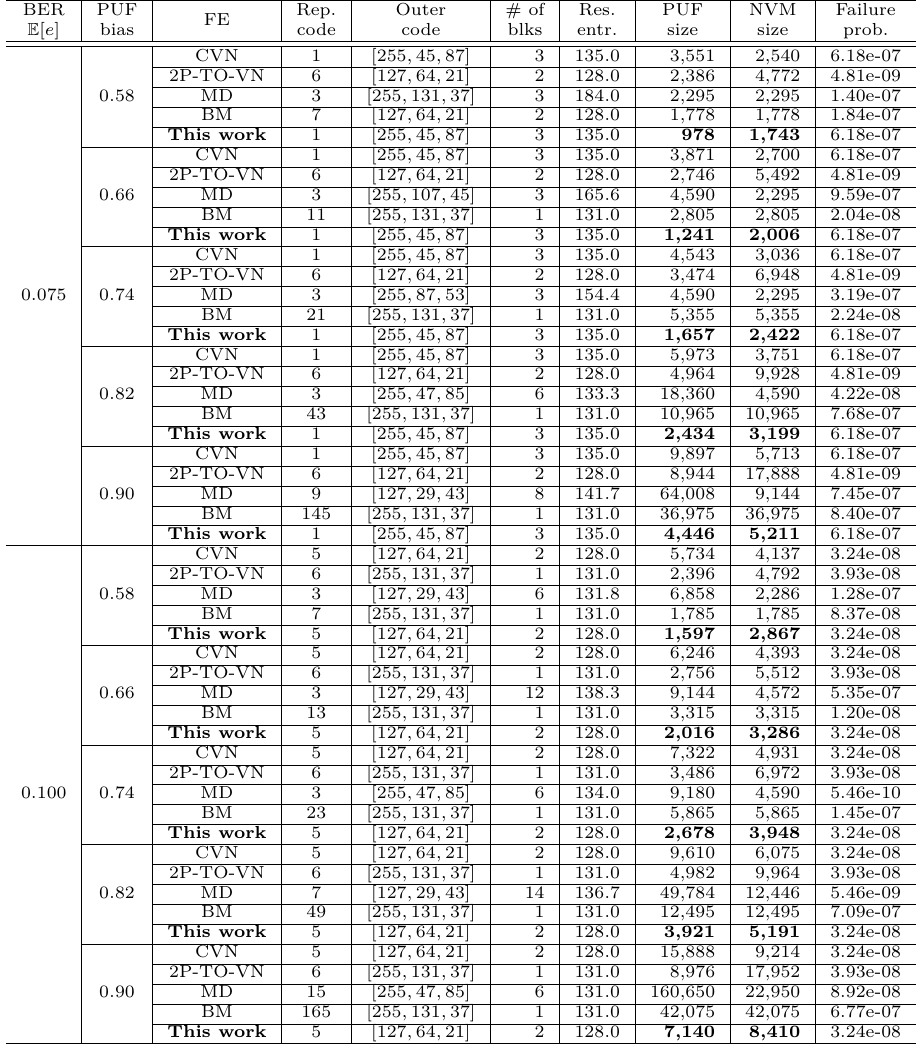
Table 5: Simulation results of 128-bit key generation using proposed and conventional binary debiasing-based FEs for averaged BER E [ e ] = 0 . 075 and 0 . 100 BER PUF FE Rep. Outer # of Res. PUF NVM bias code code